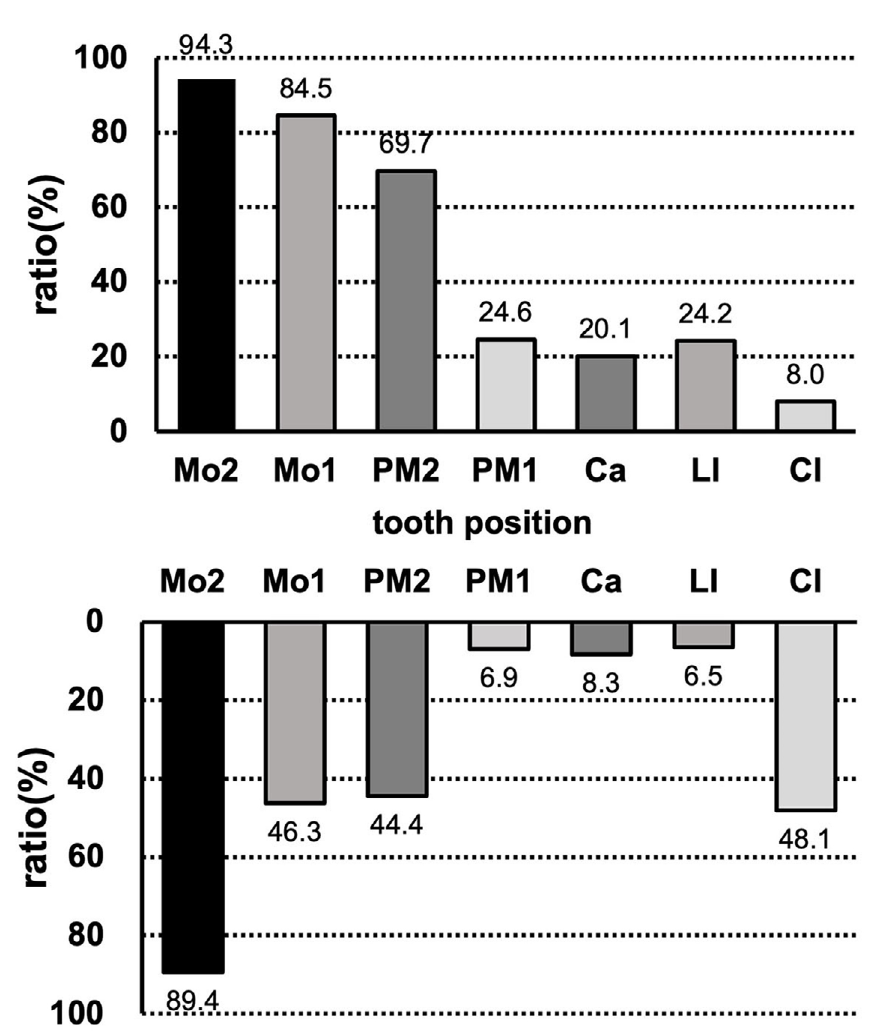
Figure 5- Permanent tooth loss rate of the upper and lower jaws of NSO patients with PAX9 variants